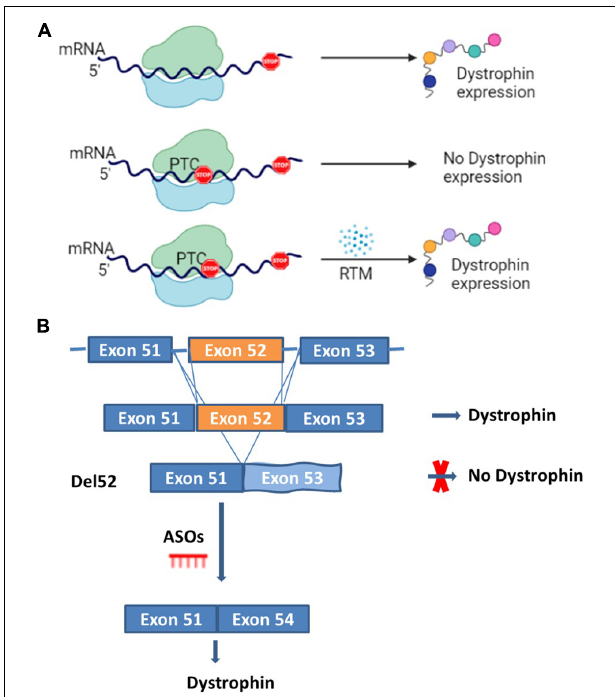
FIGURE 2 | Read through and ASOs strategies. Panel (A) represents the normal dystrophin expression and a scenario where premature termination codon (PTC) is present and induces the absence of the dystrophin expression which can be restored by read through mutation molecules (RTM). Panel (B) represents a scenario for the DMD mutation amenable to exon 52 deletion (del52). In the presence of exon 52 there is dystrophin expression, in the case of exon 52 deletion, there is no dystrophin expression. Dystrophin expression can however be restored by inducing the skipping of exon 53 with anti-sense oligonucleotides